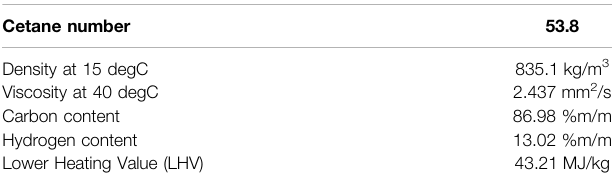
TABLE 1 | Properties of the certi fi ed diesel fuel used in current ROI measurements. Cetane number